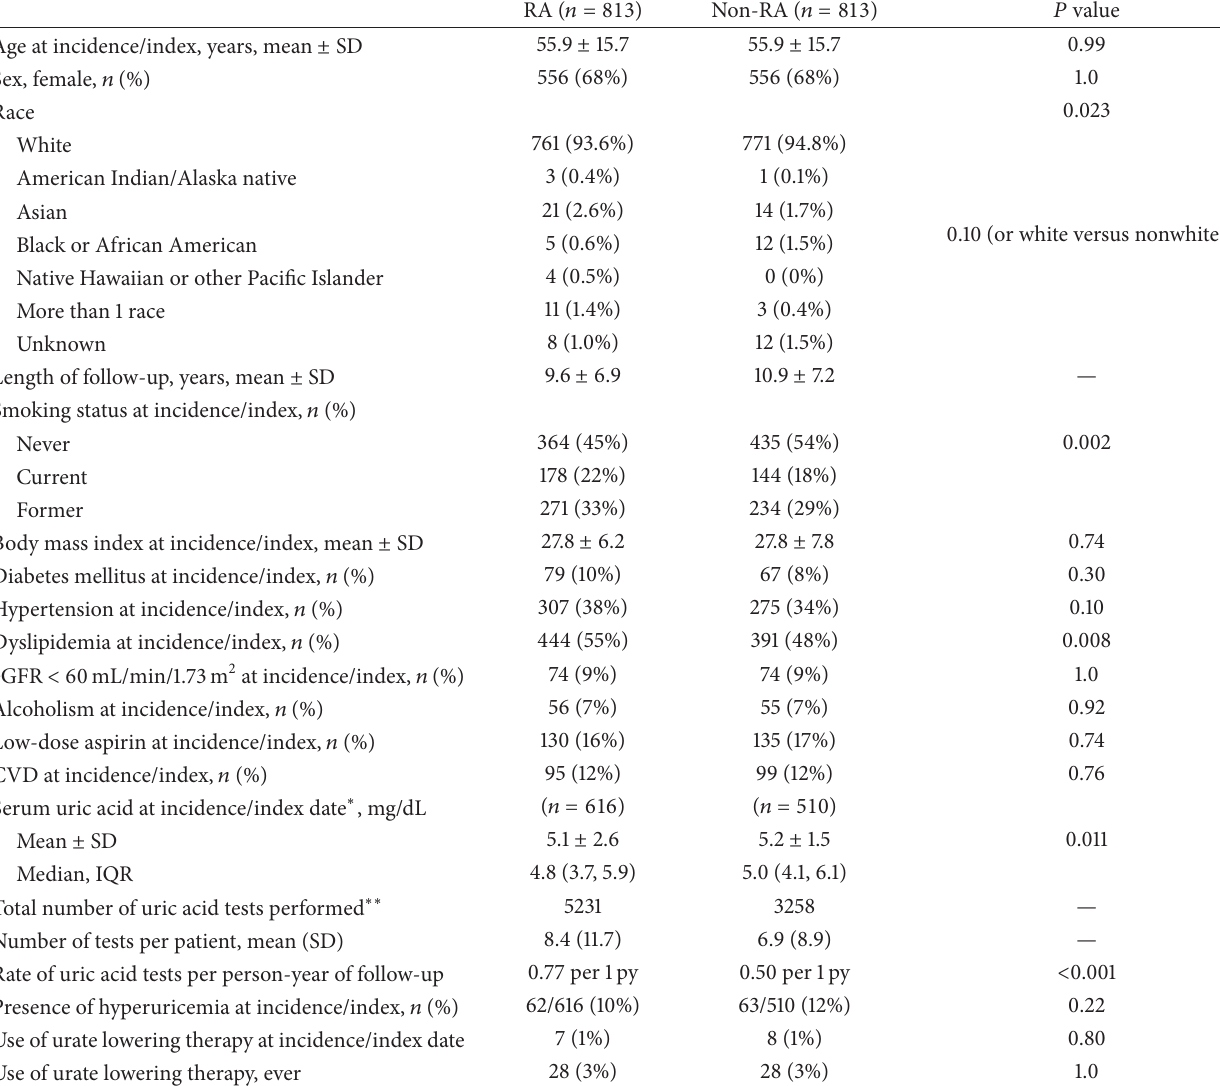
Table 1: Characteristics of 813 patients with rheumatoid arthritis (RA) and 813 subjects without RA (non-RA).